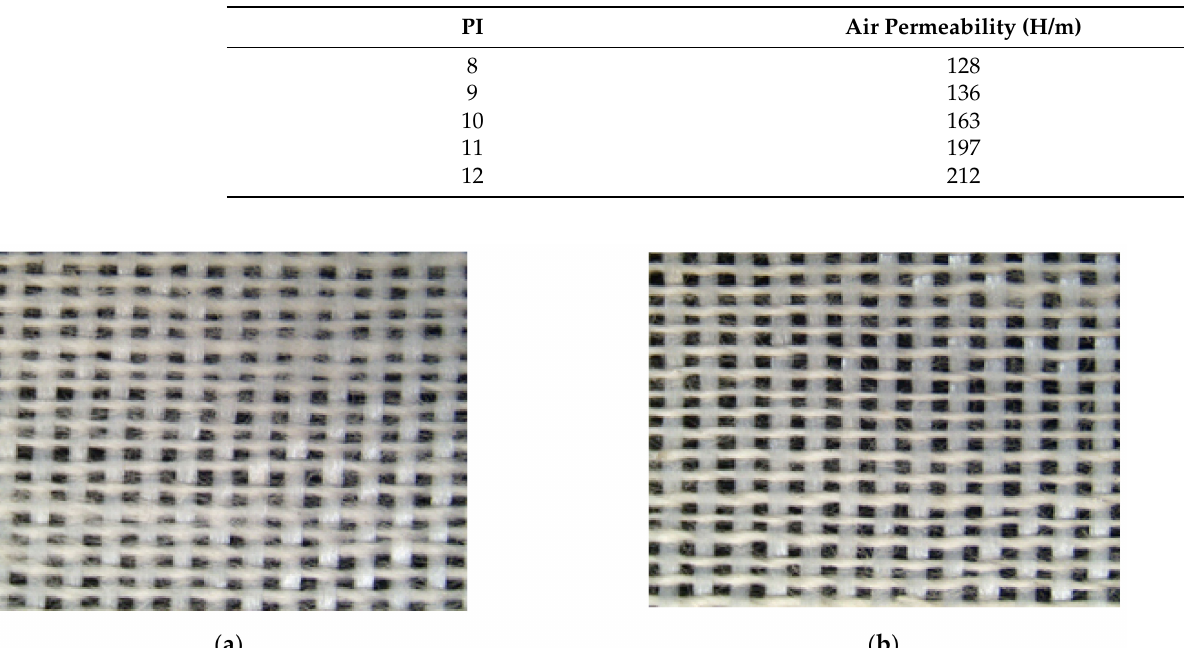
Figure 9. Air permeability of non-woven fabrics composed of Ge/SS core-spun yarns. Table 4. Air permeability of non-woven fabrics.